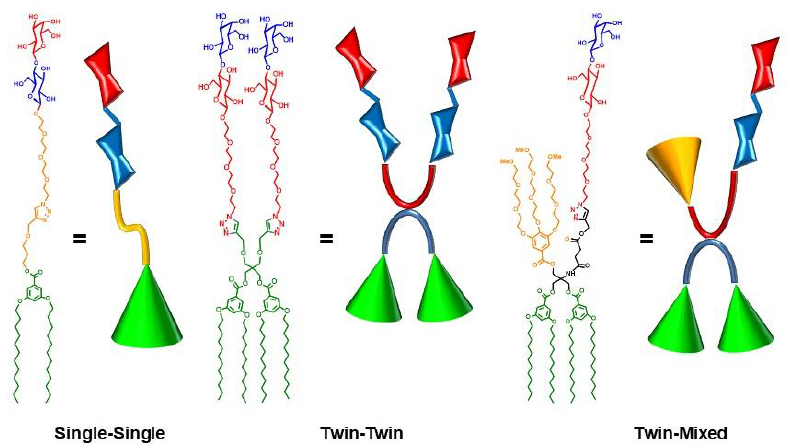
Figure 4. Structural representations of three families of neoglycolipids using ratios of the hydro- philic sugar head groups and hydrophobic lipid tails from the classical 1:2 (single-single); 2:4 (twin-twin); and heterobifunctional 1/3:4 (twin-mixed) [31].